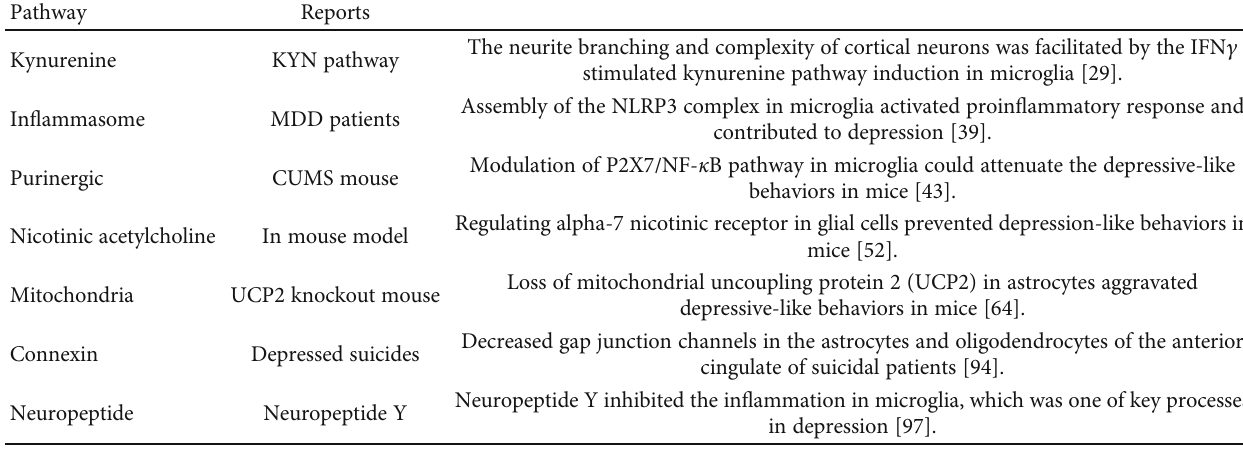
Table 1: Summary of the pathways in